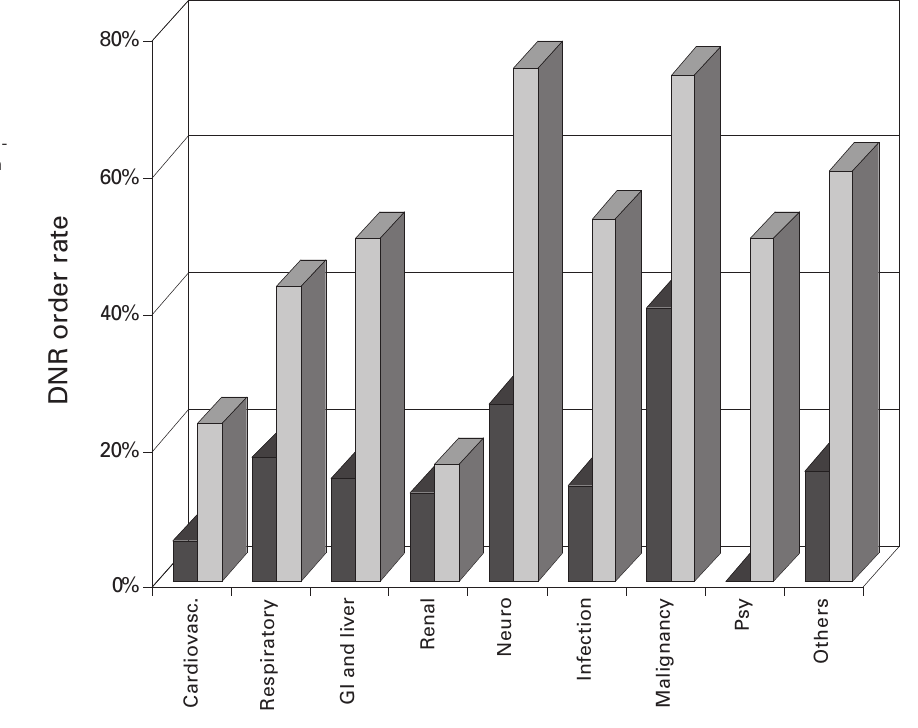
variate associations of DNR orders with age, phys- ical and/or social dependence and the admission diagnoses cardiac disease and malignancy for group 1 (table 2), and with age, physical and/or so- cial dependence and the admission diagnoses neu- rological disorders and malignancy (table 2). Ad- dition of in-hospital death as a covariate to the final multivariate model for group 1 did not alter the se- lection of parameters (table 2).